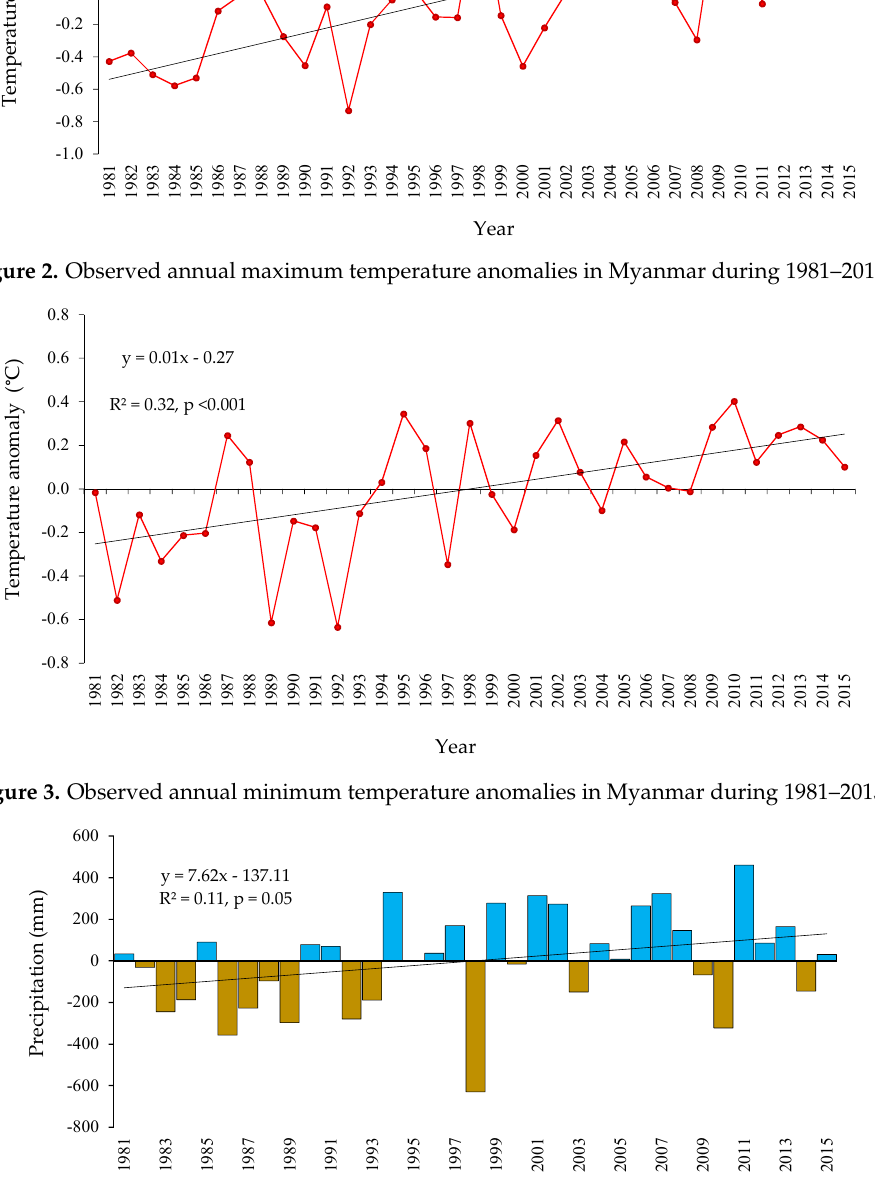
Figure 4. Observed annual total precipitation anomalies in Myanmar during 1981–2015.